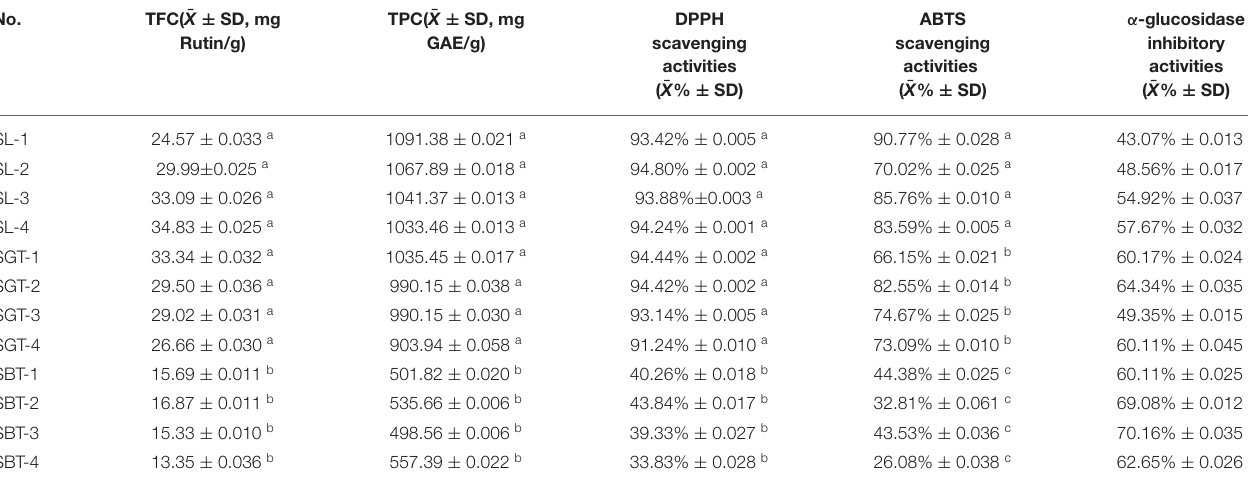
TABLE 2 | Total flavonoid content (TFC), total polyphenol content (TPC), antioxidant, and α -glucosidase inhibitory activities of sea buckthorn leaves (SL), sea buckthorn leaves green tea (SGT), and sea buckthorn leaves black tea (SBT) ( n = 3).